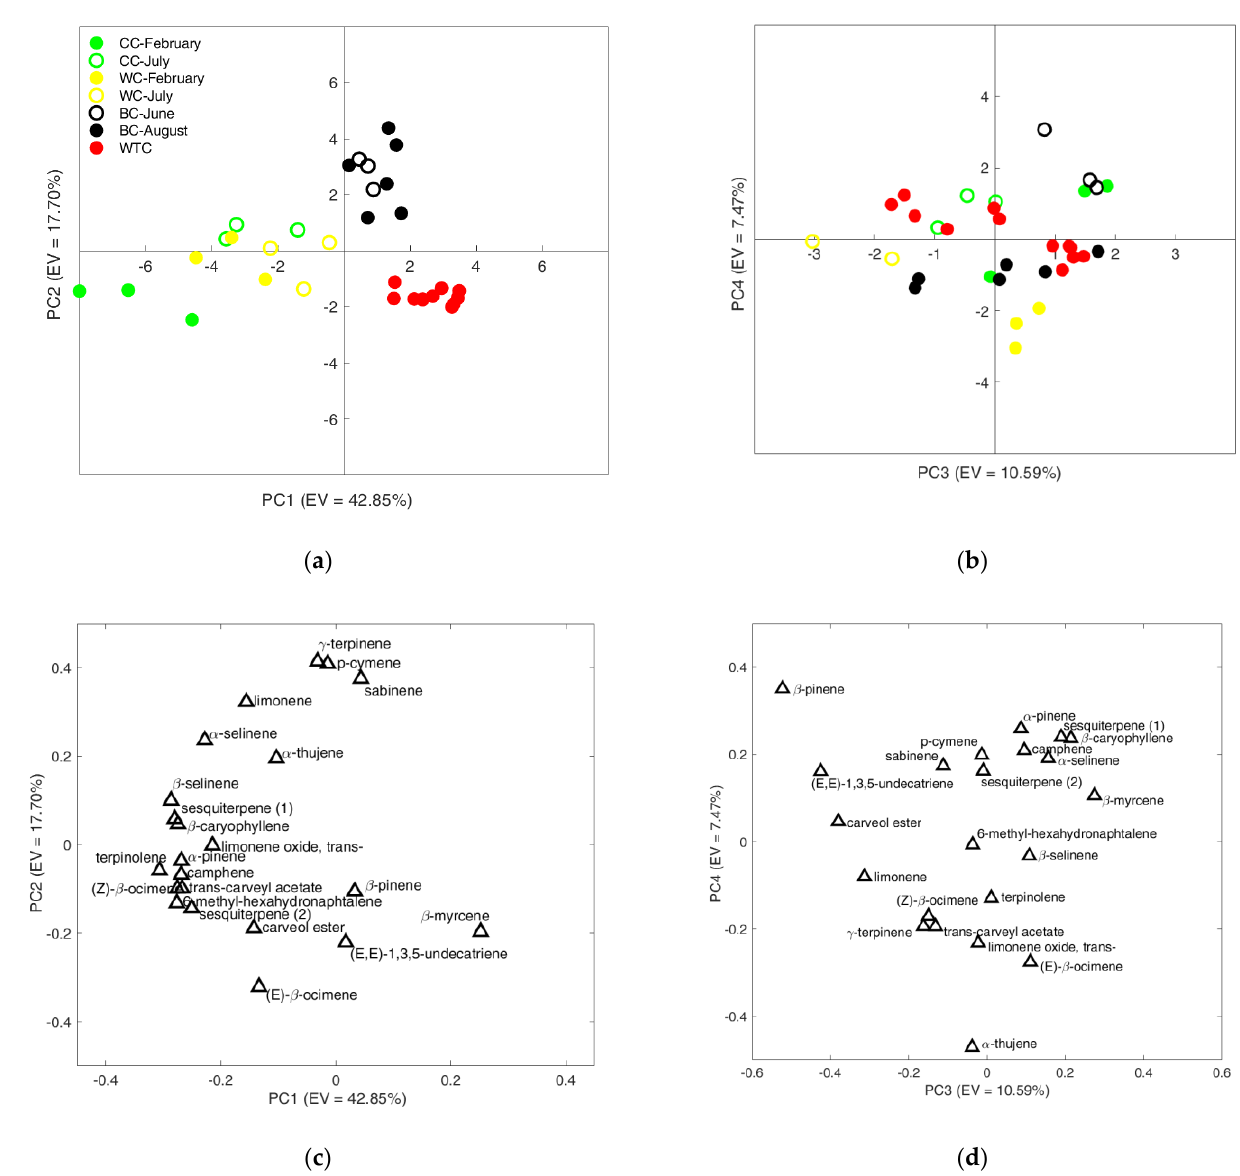
Figure 4. PCA on the volatile profiles of celery leaves after data autoscaling: ( a ) projection of the samples on the PC1-PC2 plane; ( b ) projection of the samples on the PC3-PC4 plane; ( c ) projection of the variable loadings on the PC1-PC2 plane; ( d ) projection of the variable loadings on the PC3-PC4